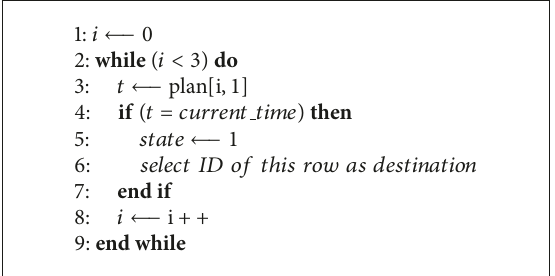
Algorithm 1: Prepare to move to resource (as planned)